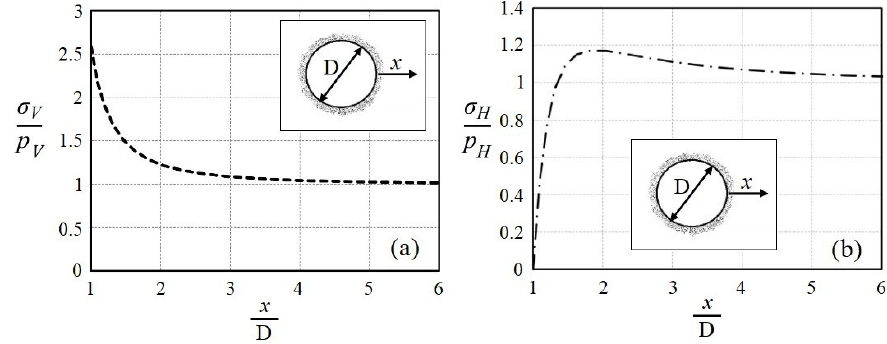
Figure A1. Sensitivity analysis on the model boundaries: ( a ) changes in stress in the rock environment, vertically; ( b ) changes in stress in the rock environment, horizontally; x is the distance from the tunnel lining, σ H is the horizontal stress in the rock, σ V is the vertical stress in the rock, P H is the initial horizontal stress in the rock, and P V is the initial vertical stress in the rock.